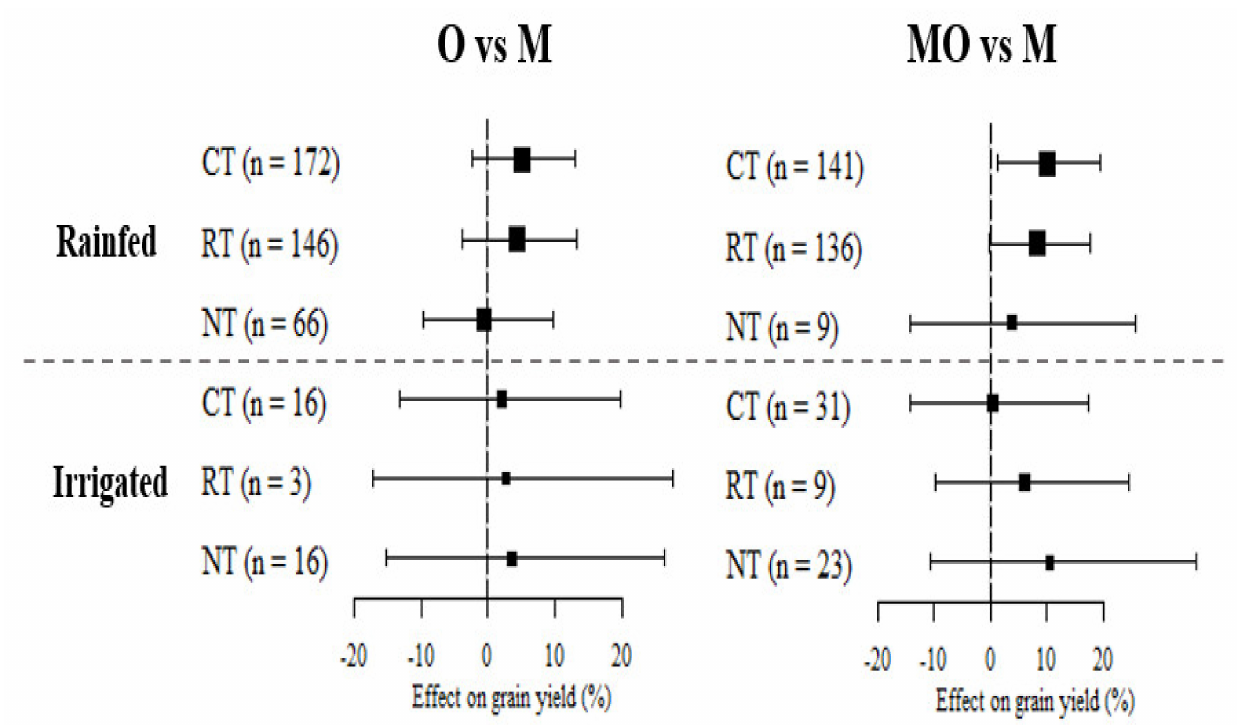
Figure 7. The crop yield response of organic vs. mineral (O vs. M), and mineral + organic vs. mineral (MO vs. M) under conventional, reduced and no-tillage practices (CT, RT, and NT, respectively) in different irrigation regimes, expressed as the average effect on crop yield (%). “n” refers to the number of observations for each subgroup. The vertical line represents the null hypothesis [ ln ( RR ) = 0]. The squares are the point estimate of effect size. The horizontal lines are the associated 95% confidence interval for the population